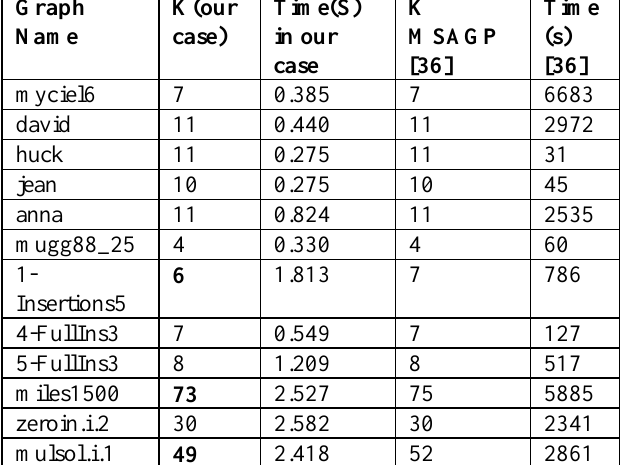
Table 10: Comparison results with modified simulated annealing [36]